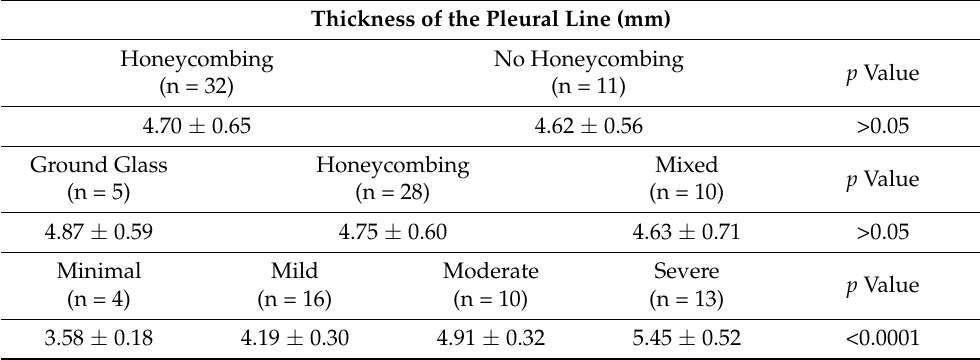
Table 2. Average thickness of the pleural line in the different groups of patients. Thickness of the Pleural Line (mm)